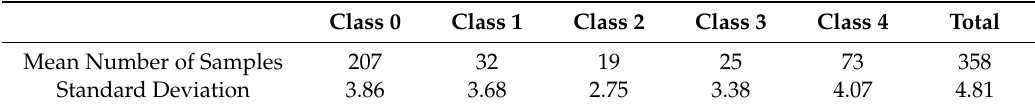
Table 3. Mean (of 100 subsets) distribution of downsized (from original) samples across classes. This downsizing was performed to remove spatial